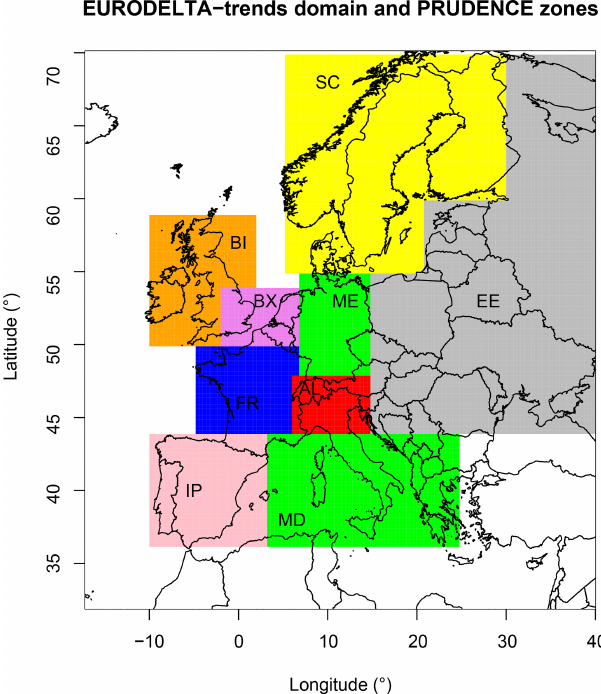
Figure 1. The extension of the EURODELTA-Trends domain as well as that of the subregions adapted from the Prediction of Re- gional scenarios and Uncertainties for Defining EuropeaN Climate change risks and Effects (PRUDENCE) zones. From south to north: Mediterranean regions (MD), Iberian Peninsula (IP), France (FR), Alps (AL), mid-Europe (ME), eastern Europe (EE), Benelux re- gions (BX), British Isles (BI) and Fennoscandia